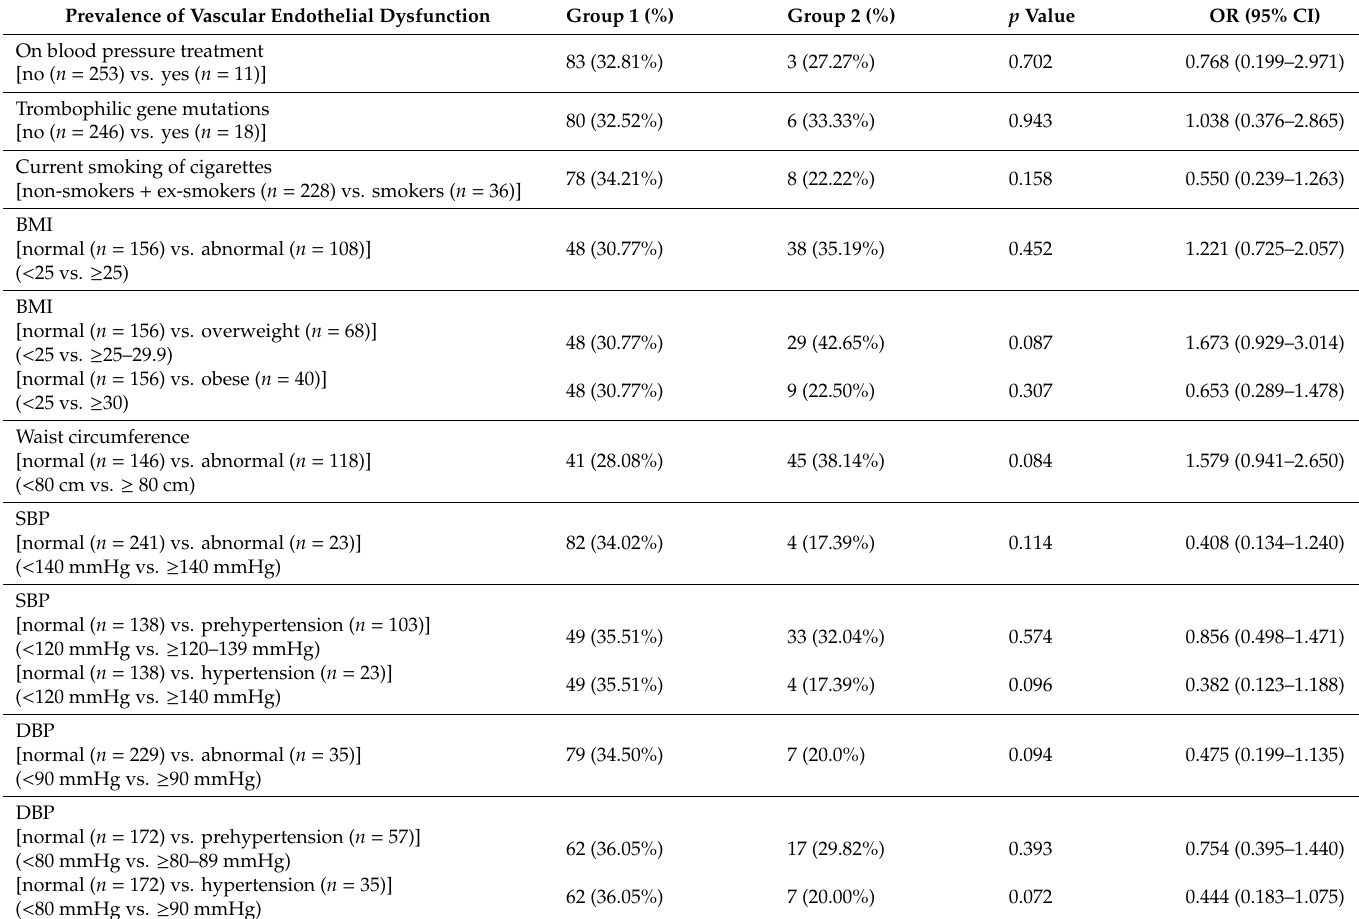
Table 2. Impact of classical cardiovascular risk factors and a history of pregnancy on the prevalence of vascular endothelial dysfunction_ overview (logistic regression